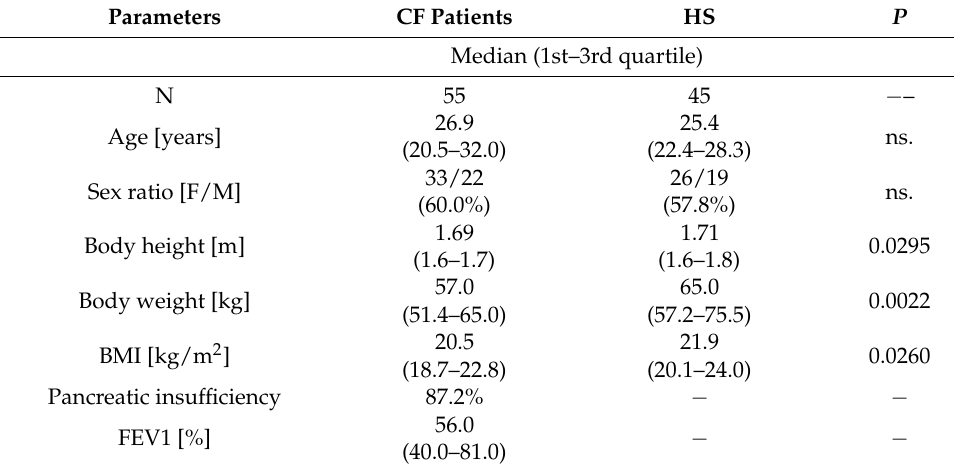
Table 1. Anthropometric and clinical data of cystic fibrosis (CF) patients and healthy subjects (HS).